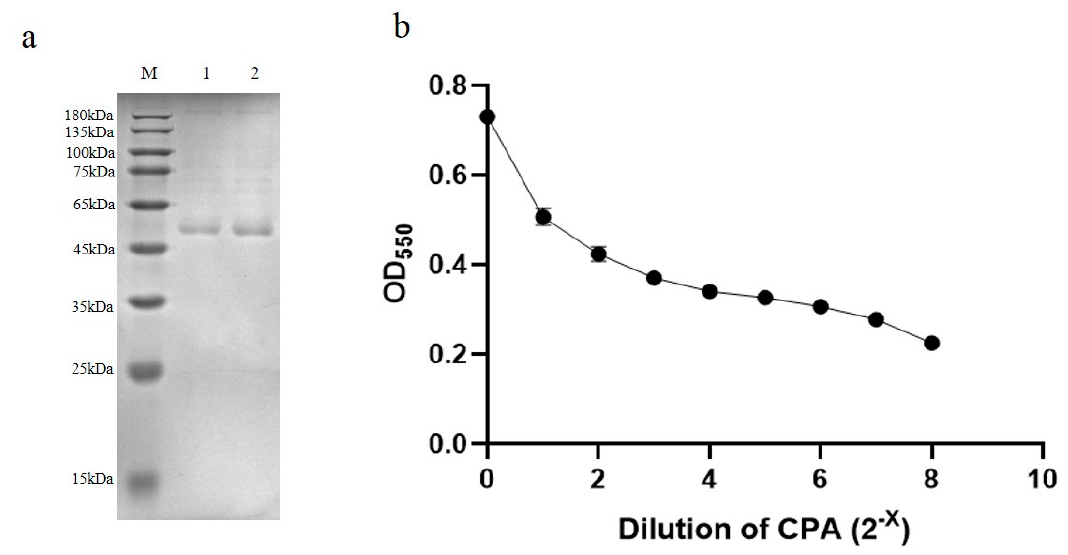
Figure 4. Crude purification and quantification of CPA ( a ) SDS-PAGE results of CPA crude purification: M: protein marker (GenStar M221), lane 1:0.21 µ g / mL crude purified CPA (40 times concentrated), lane 2: 0.42 µ g / mL crude purified CPA (80 times concentrated); ( b ) degree of hydrolysis of CPA by lecithin hydrolysis